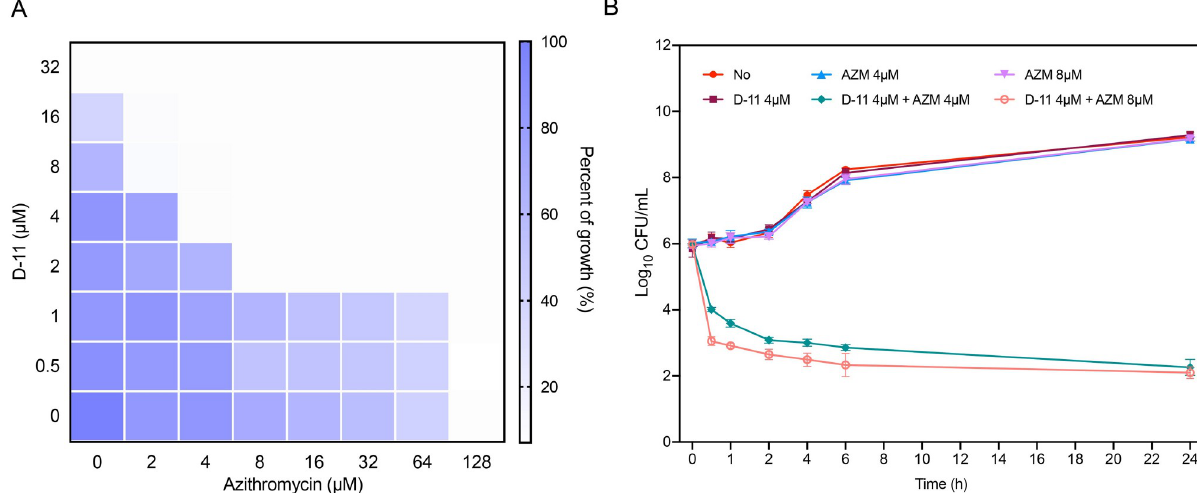
Fig 1. D-11 synergizes with azithromycin against P . aeruginosa . ( A ) Representative heat plots of the microdilution checkerboard assay for the combination of azithromycin and D-11 against PAO1. ( B ) Time killing curves for D-11 and azithromycin monotherapy and combination therapy against PAO1 during 24 h incubation at the indicated concentrations. Error bars represent mean ± SD for three biological replicates.